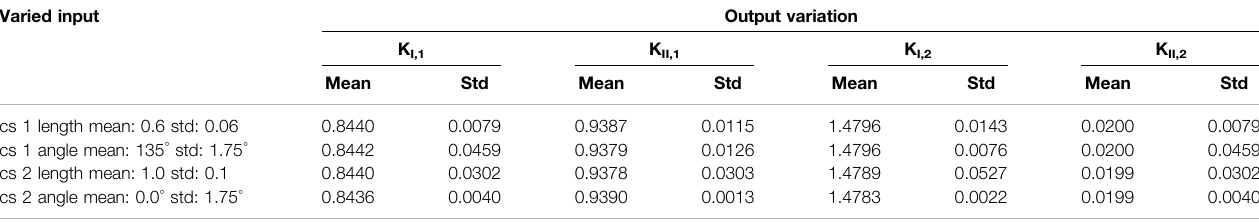
TABLE 1 | UQ results for each input parameter relative to the output parameters. Varied input